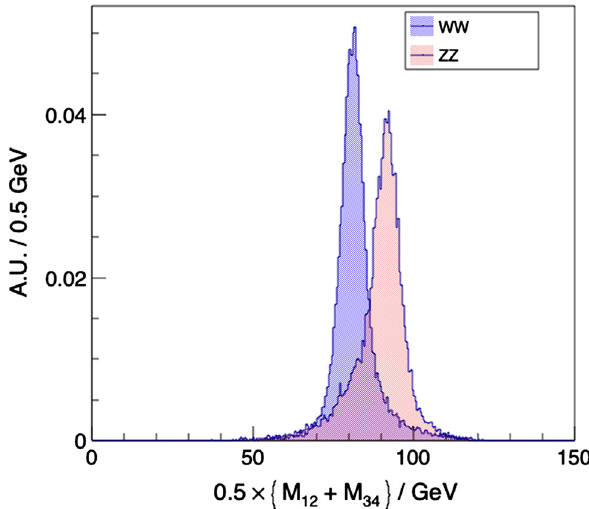
Fig. 10 The RecoJet level distributions of 0 . 5 × ( M 12 + M 34 ) with the equal mass condition, the overlapping fraction is 39 . 9% ± 0 . 40%